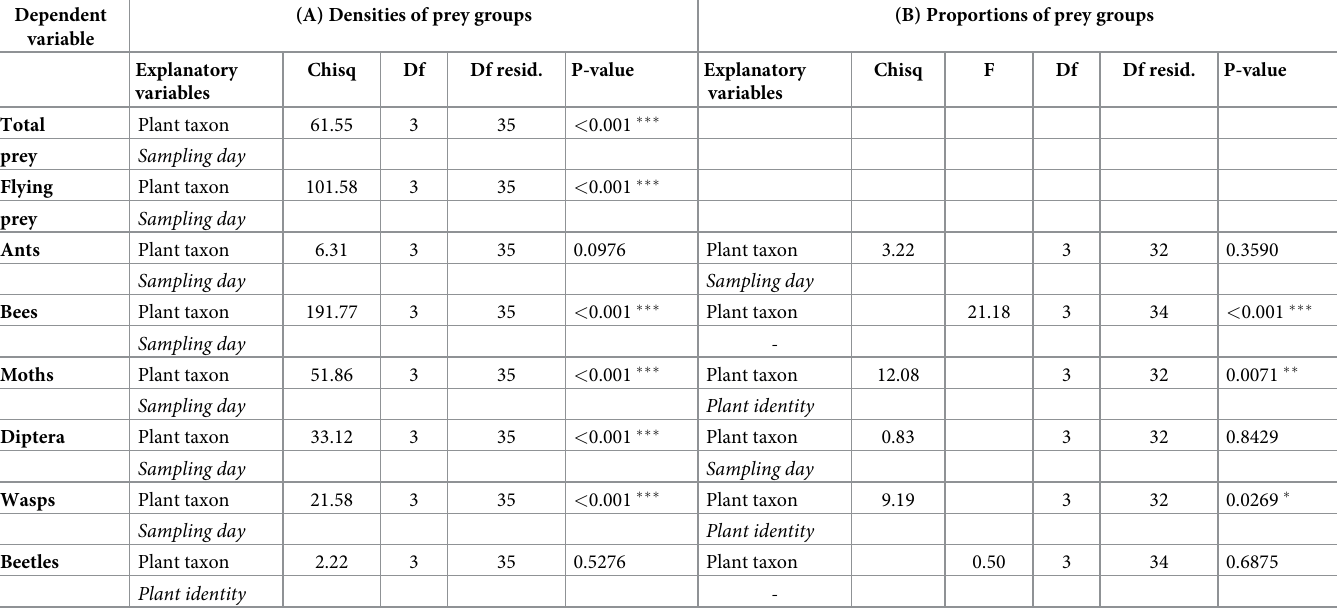
Table 3. Interspecific difference in prey